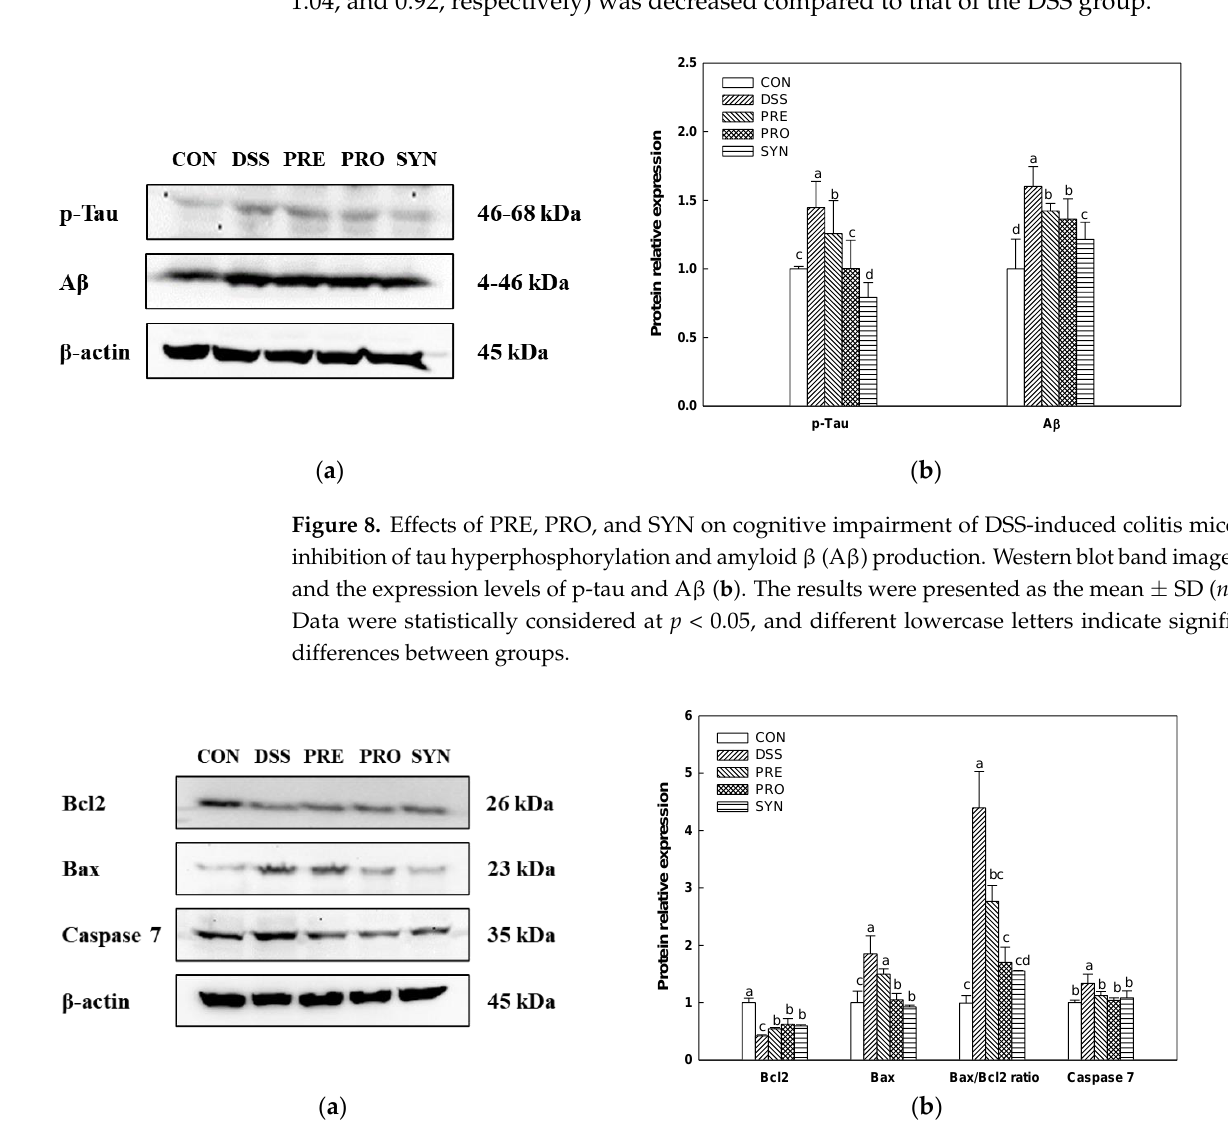
Figure 9. Effects of PRE, PRO, and SYN on cognitive impairment of DSS-induced colitis mice via regulation of apoptosis pathway. Western blot band images ( a ), and the expression levels of Bcl2, Bax, Bax/Bcl2 ratio, and caspase 7 ( b ). The results were presented as the mean ± SD ( n = 3). Data were statistically considered at p < 0.05, and different lowercase letters indicate significant differences between groups.